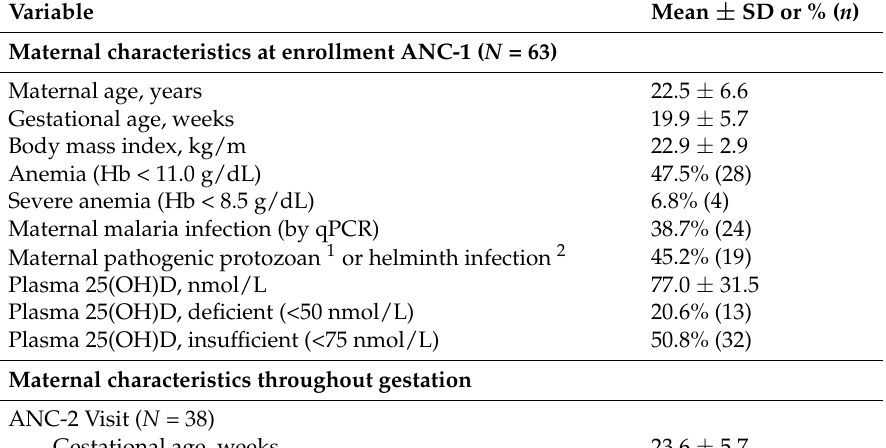
Table 1. Characteristics of the study population, enrollment through to birth.